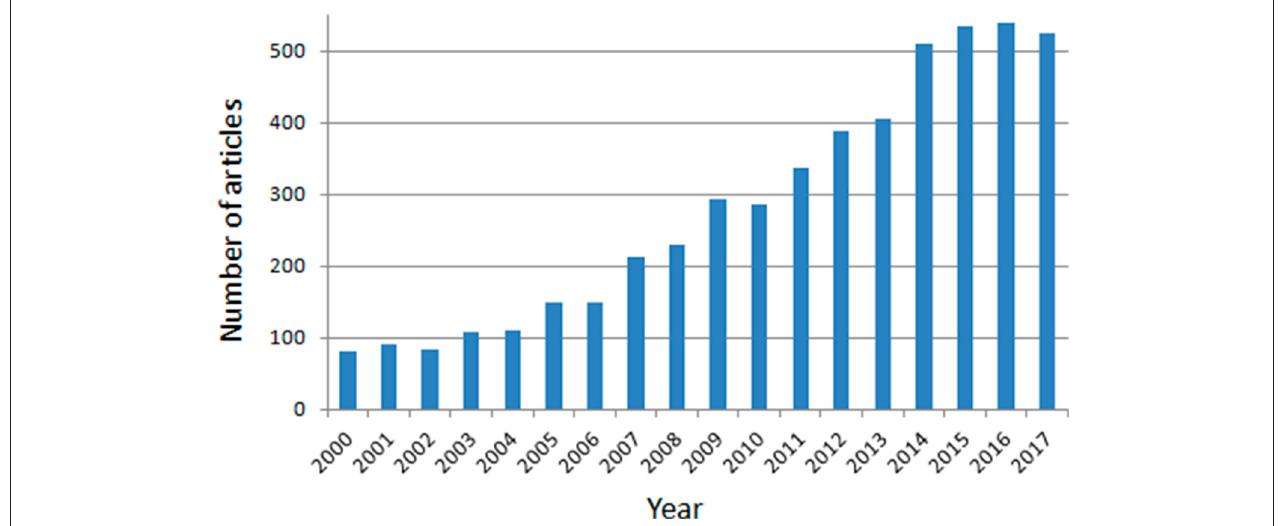
FIGURE 1 | Number of articles involving binge drinking during adolescence and youth for the period 2000–2017. The search strategy was conducted in PubMed with the following key terms: [(“binge drinking” OR “binge drinkers” OR “heavy drinking” OR “heavy drinkers” OR “heavy episodic drinking” OR “college drinking” OR “college drinkers” OR “social drinkers”) AND (adolescen* OR youth* OR teen* OR “young” OR “young adults” OR “college students” OR “university